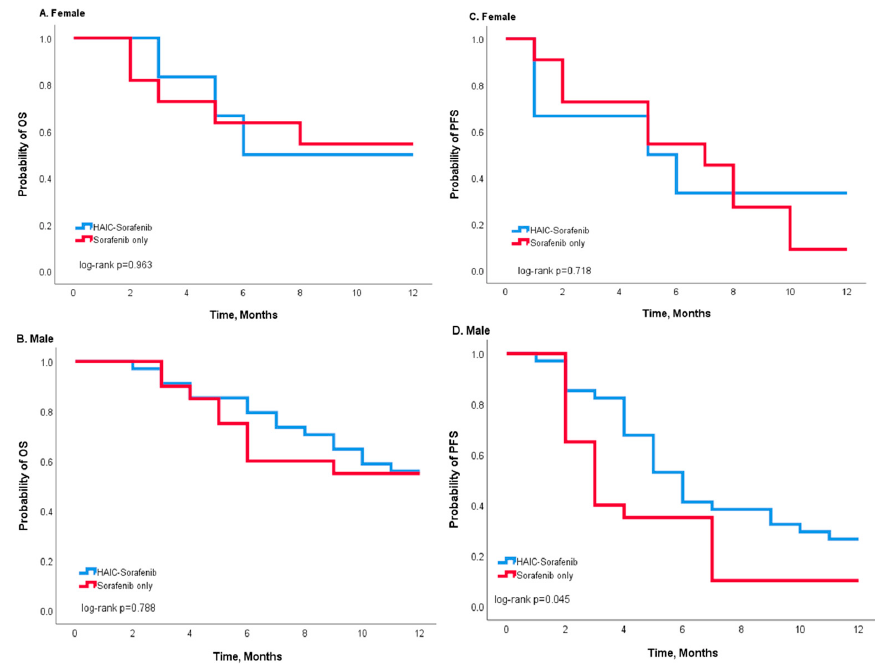
Figure 4. Kaplan–Meier survival analysis according to different treatments (HAIC-sorafenib versus sorafenib alone) for patients of different genders: ( A , B ) OS and ( C , D ) PFS. The log-rank test indicates no significant differences between the survival curves for females ( A , C ). For male patients, the survival curve shows a better OS and PFS ( B , D ), and a significant difference was noted in PFS ( p = 0.045 in ( D )) according to the log-rank